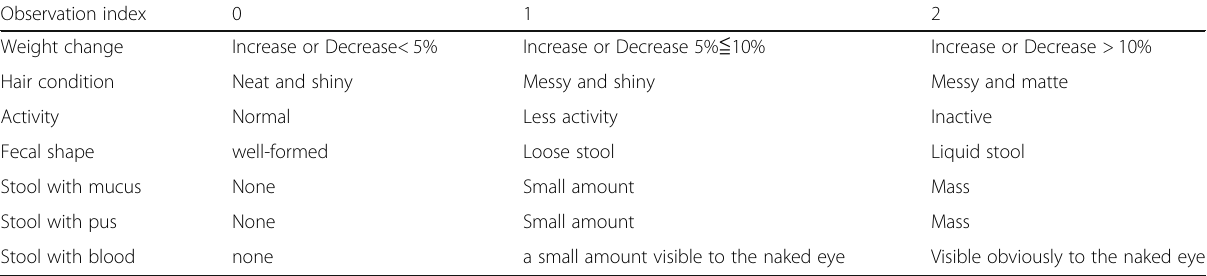
Table 2 Scoring of disease activity index Observation